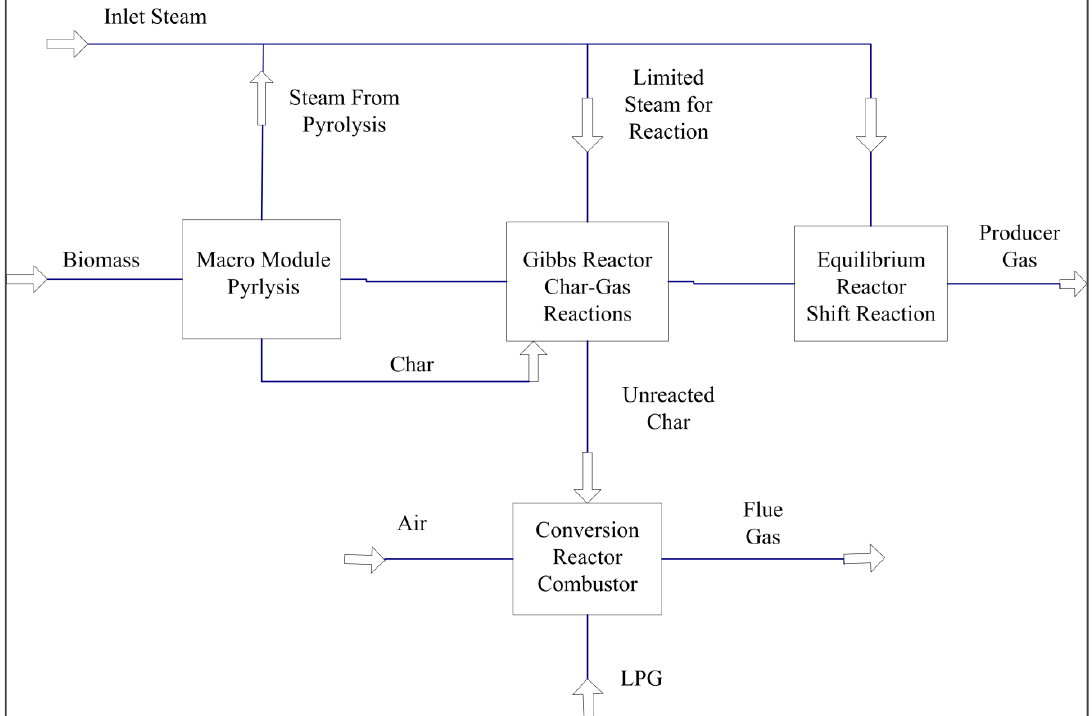
Figure 3. An overview of the DFB gasifier model developed in UniSim